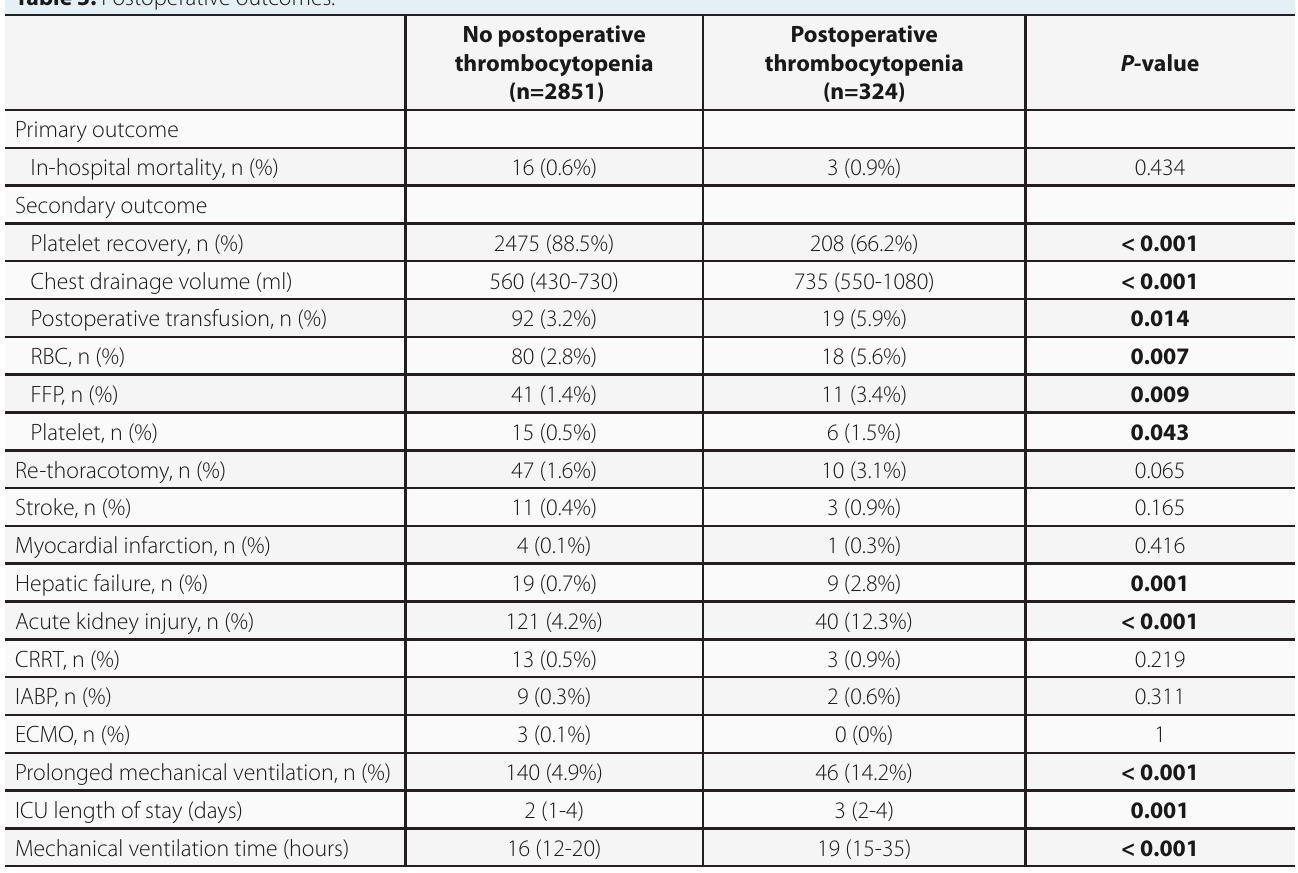
Table 3. Postoperative outcomes.